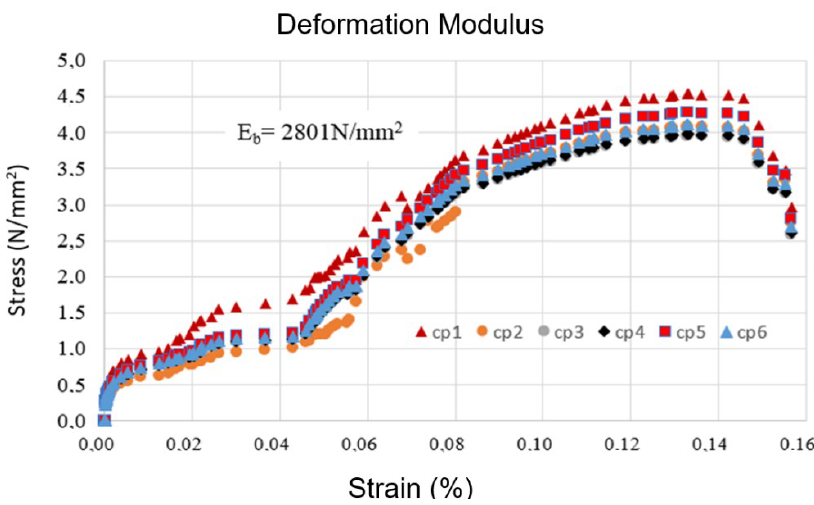
Figure 7. Distribution of the accumulated likelihood (PBB).